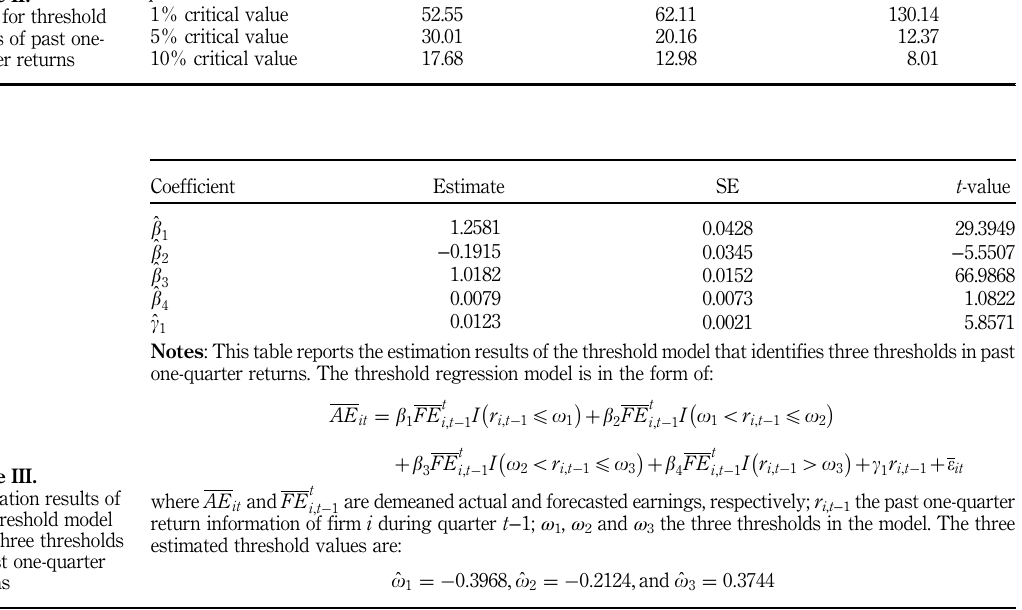
Table II. Tests for threshold effects of past one- quarter returns